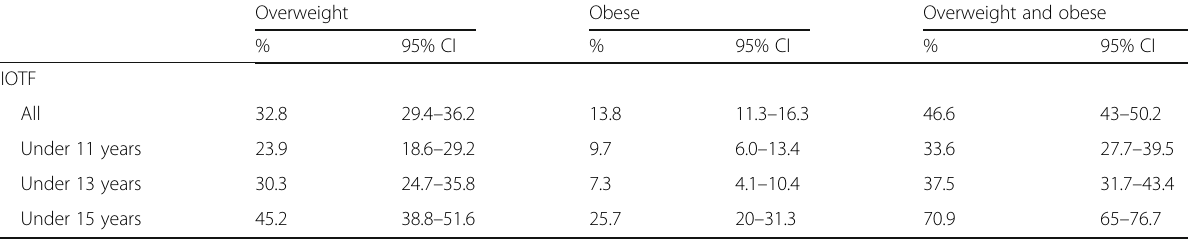
Table 1 Prevalence of overweight and obesity in young rugby players by age category (IOTF criteria) Overweight